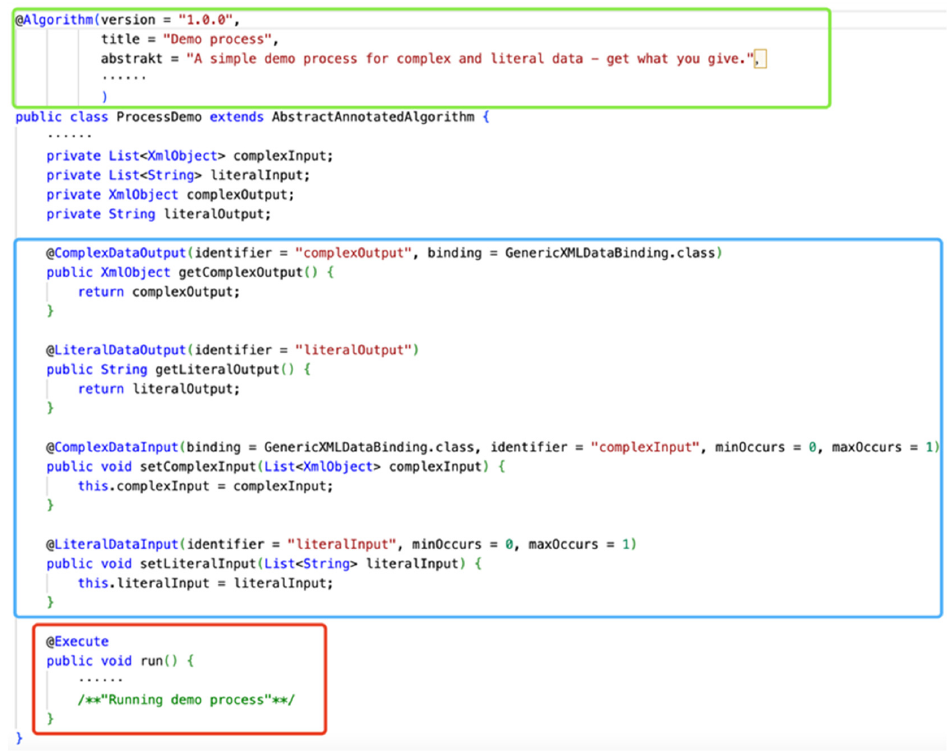
Figure 7. Example of WPS definition template file. The green box contains metadata of the service; the blue box contains the definitions of inputs and outputs; the red box contains the actual operation.